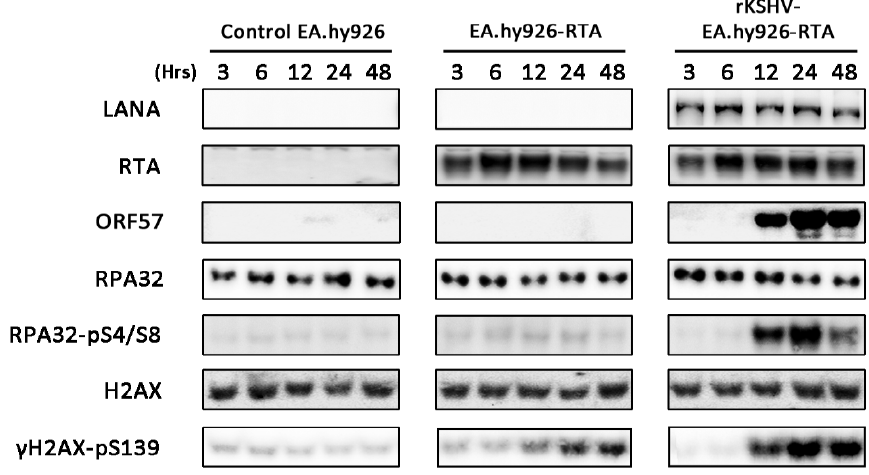
Figure 7. Activation of the DNA damage response during lytic replication of KSHV in EA.hy926 cells and following RTA expression